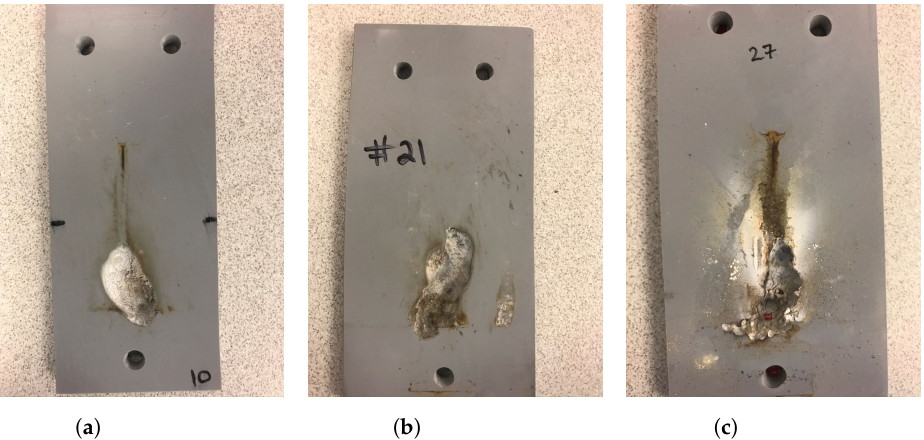
Figure 2. Examples of erosion damage on high temperature vulcanized (HTV) silicone rubber (SR) samples following IPT: ( a ) Sample #10 after the AC test with an erosion depth of 4.7 mm. ( b ) Sample #21 after − DC test with an erosion depth of 5.4 mm. ( c ) Sample #27 after + DC test with an erosion depth of 6.0